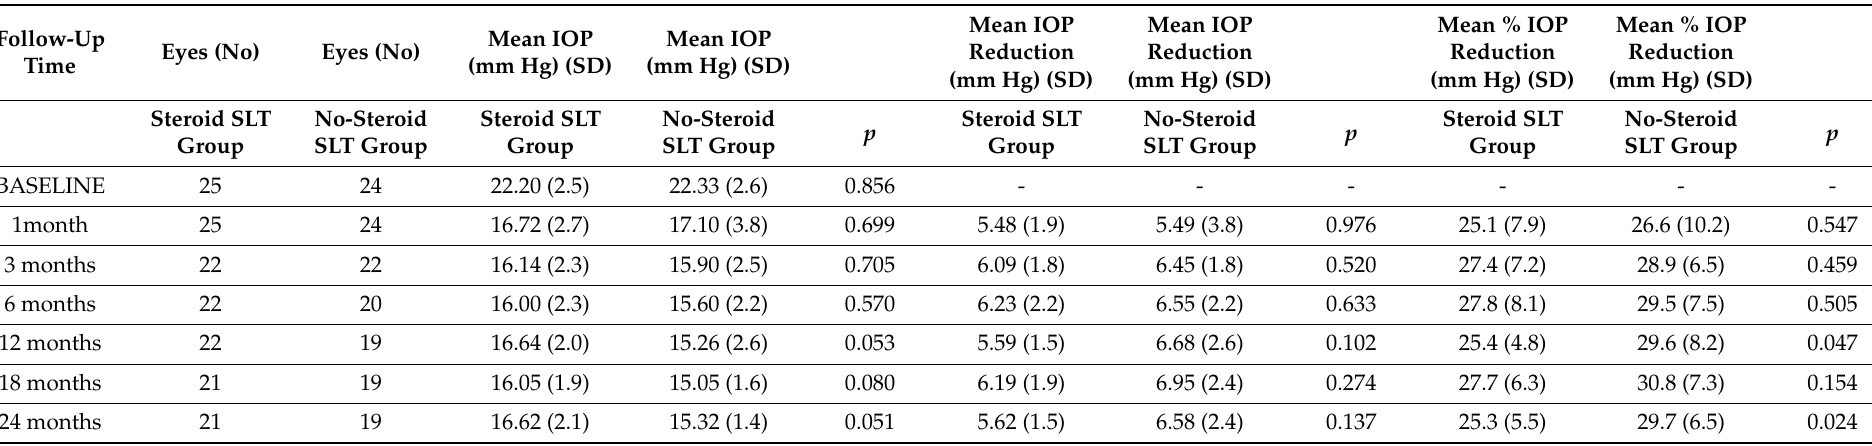
Table 2. Mean IOP, mean IOP reduction, and mean percent IOP reduction from baseline IOP at different time intervals following SLT–all